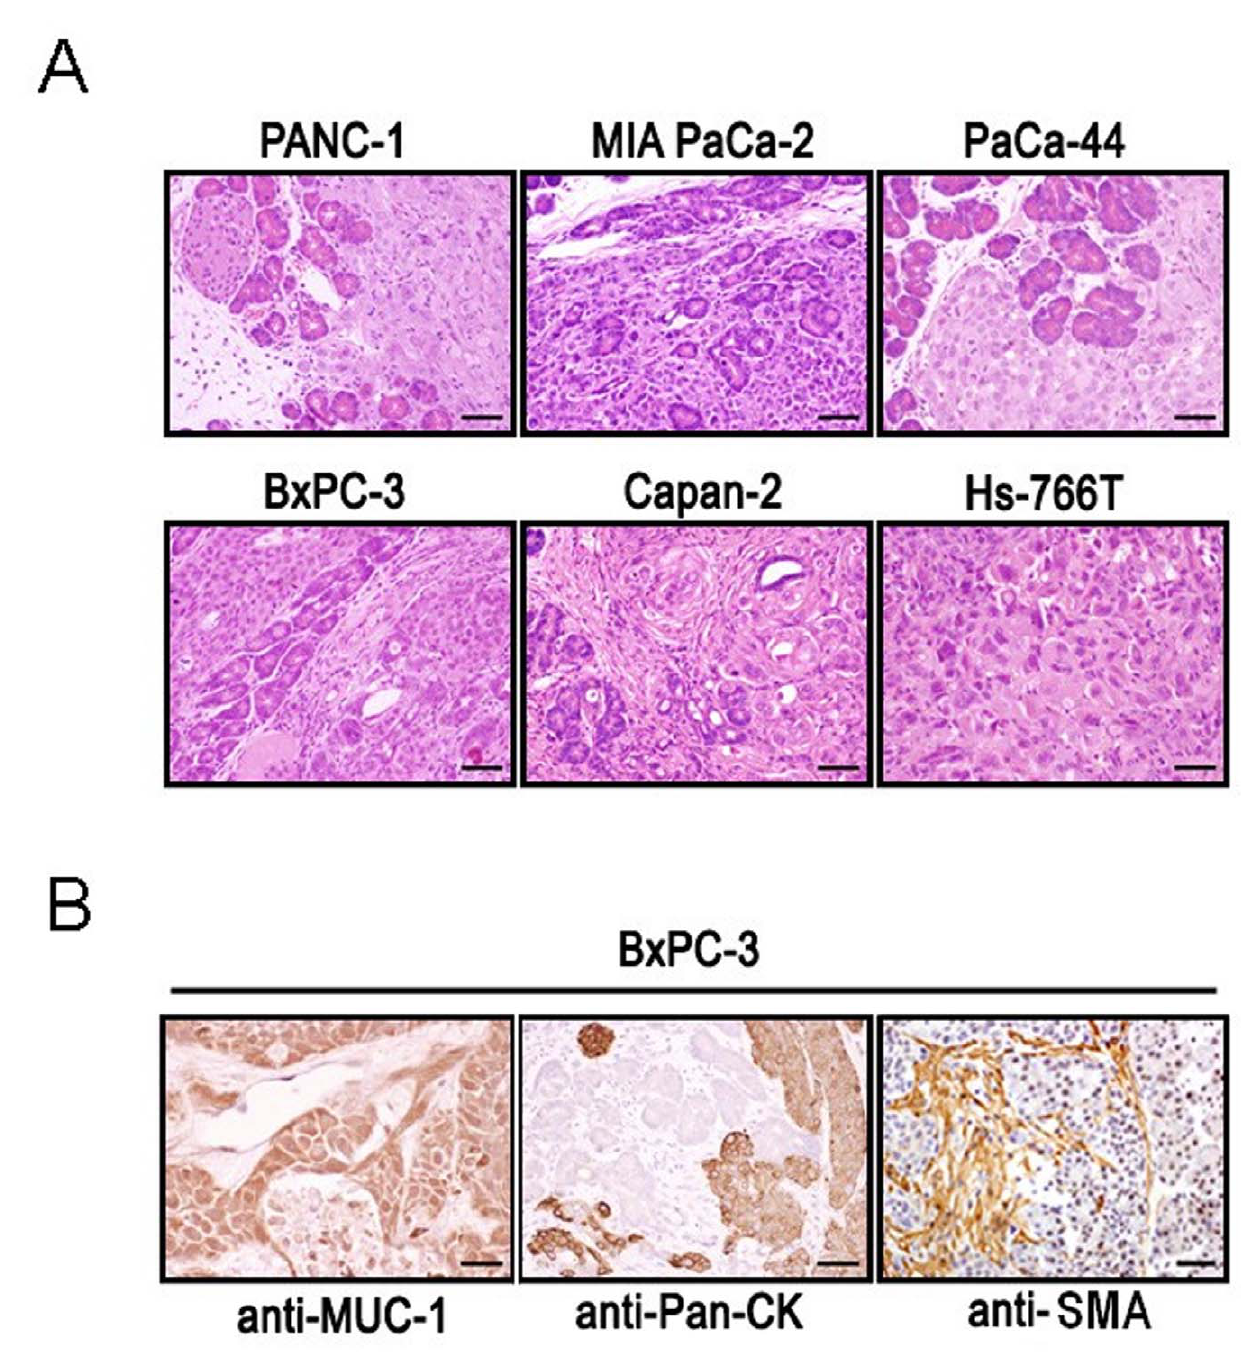
Figure 2. Pathohistological analyses of tumor tissues. ( 2A ) Sections of pancreatic tumors derived of the indicated pancreatic cell lines were stained with haematoxylin and eosin. The Hs-766T specimen was dissected from a subcutaneous tumor; all other samples were taken from orthotopically grown tumors. ( 2B ) Different sections of a BxPC-3-derived tumor were subjected to immunohistological analysis with antibodies against Mucin-1 (MUC-1), pan-cytokeratin (Pan-CK), and a -smooth muscle actin (SMA). The black bar represents a length of 53 m m, except for anti- MUC-1 staining (27 m m).